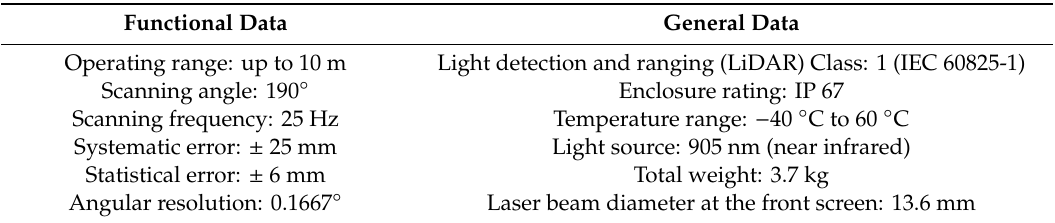
Table 1. LMS 511 specification data